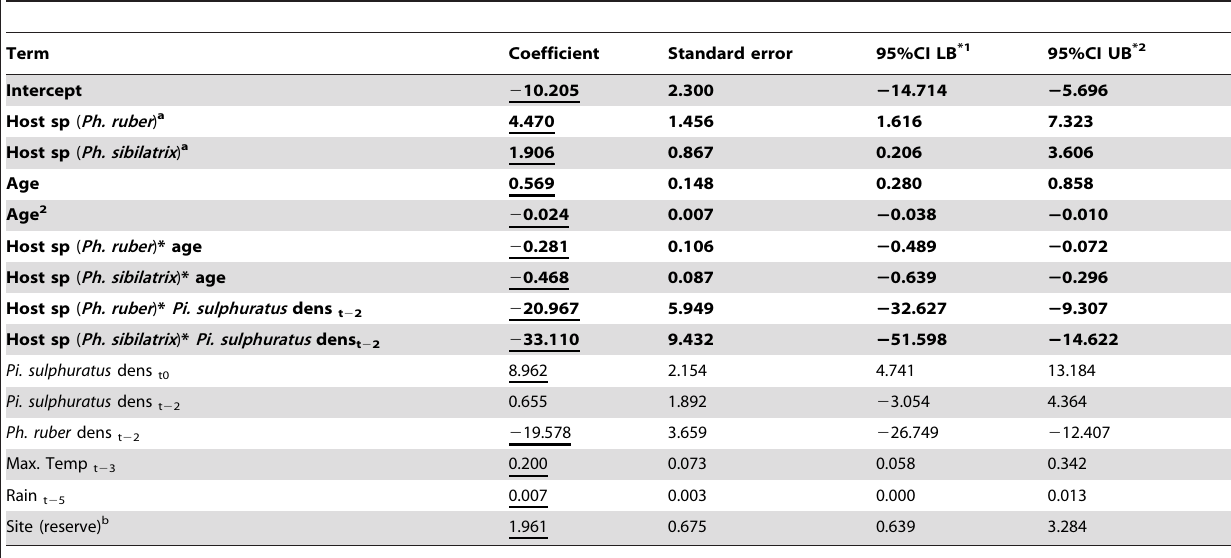
Table 2. Parameters of the best model describing individual factors associated with P. torquans infection in its predominant hosts.